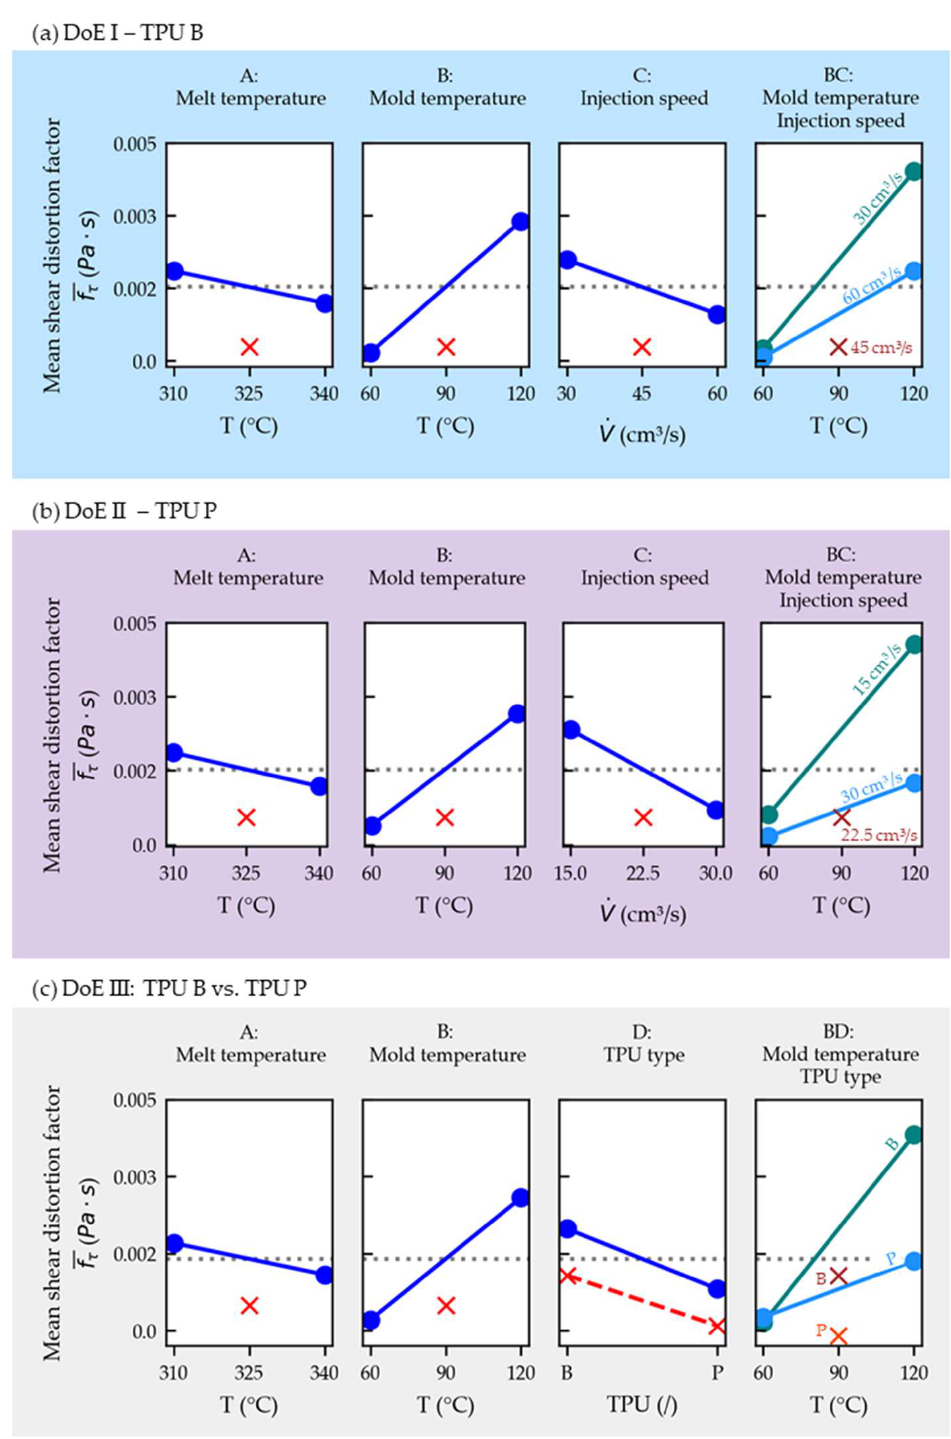
Figure 9. Main effects and interaction plots (including center points in red) for the averaged shear distortion factor ( f τ ) for DoE I ( a ), II ( b ) and III ( c ). The factor designations (A, B, C and D) relate to Table